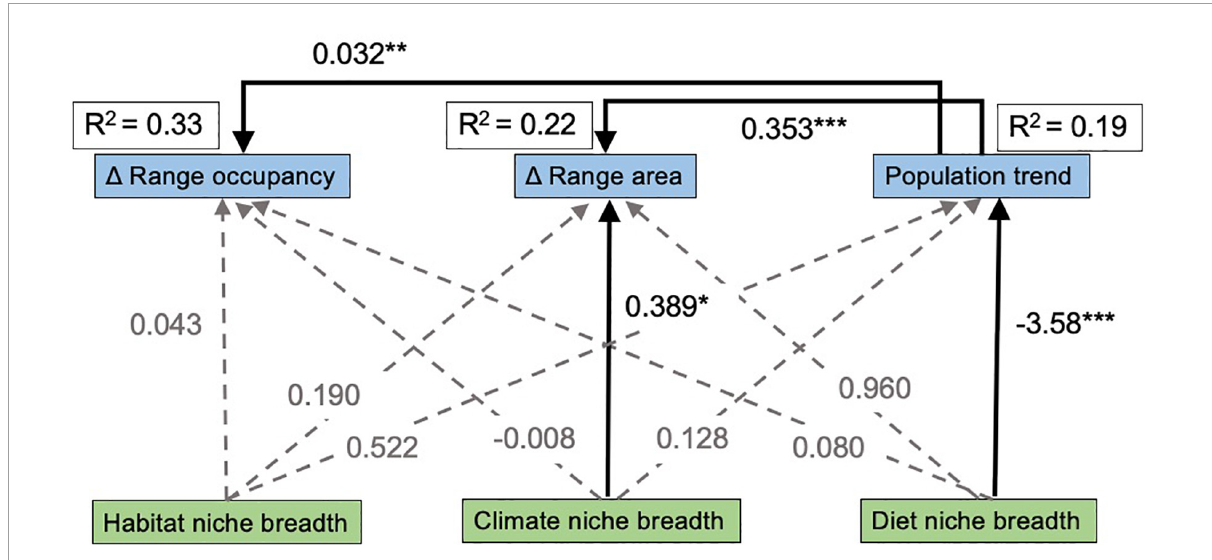
FIGURE4 Path diagram showing results of structural equation model relating species niche breadth to changes in species ranges. Black, solid lines indicate significant relationships, while gray, dotted lines indicate no support for a causal path between those variables. Point estimates of the effect size for each directional relationship are next to each line, with significance levels indicated: p < 0.05 *, p < 0.01 **, p < 0.001 ***. The overall R 2 for each response variable is outlined in a box next to each variable